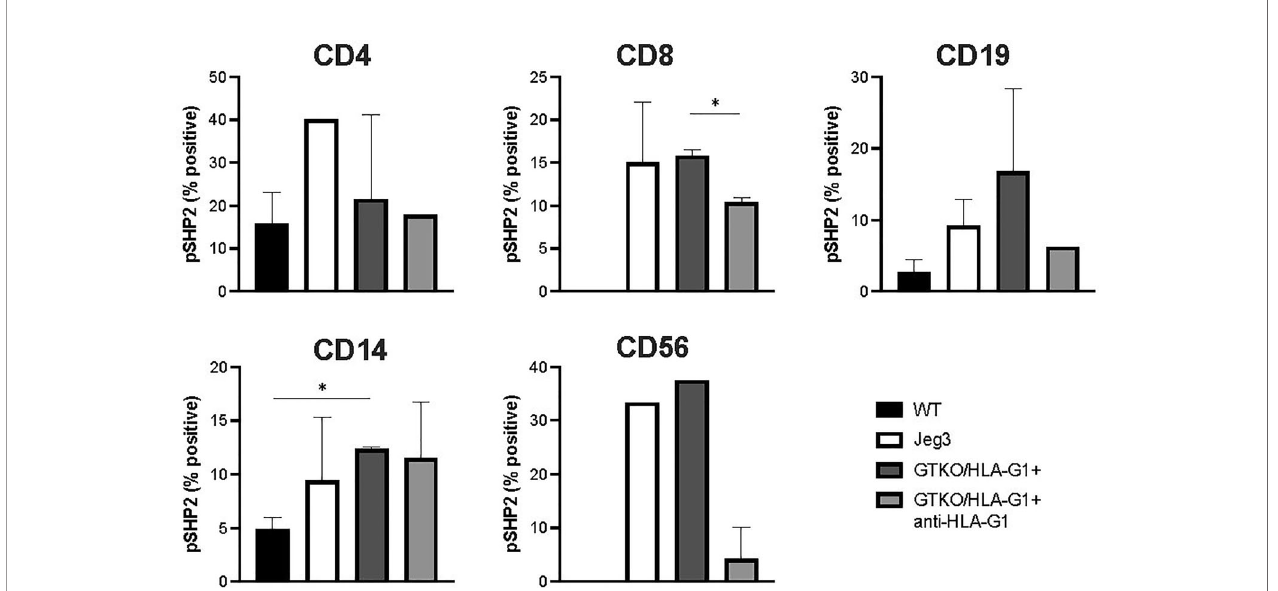
FIGURE 7 | Skin fi broblasts derived from HLA-G + porcine cells increase phosphorylation of SHP-2 in various subsets of human PBMCs. Proportion of CD4 + , CD8 + SHP-2 + T cells subset; CD19 + SHP-2 + subset; CD14 + SHP-2 + B cells subset; CD56 + SHP-2 + NK cells subset. Prior to addition of HLA-G + skin fi broblasts, hPBMCs were stimulated with anti-CD3/anti-CD28 cocktail for 72h, as per manufacturer instructions. In order to measure SHP-2 phosphorylation in B cells, hPBMCs were stimulated with